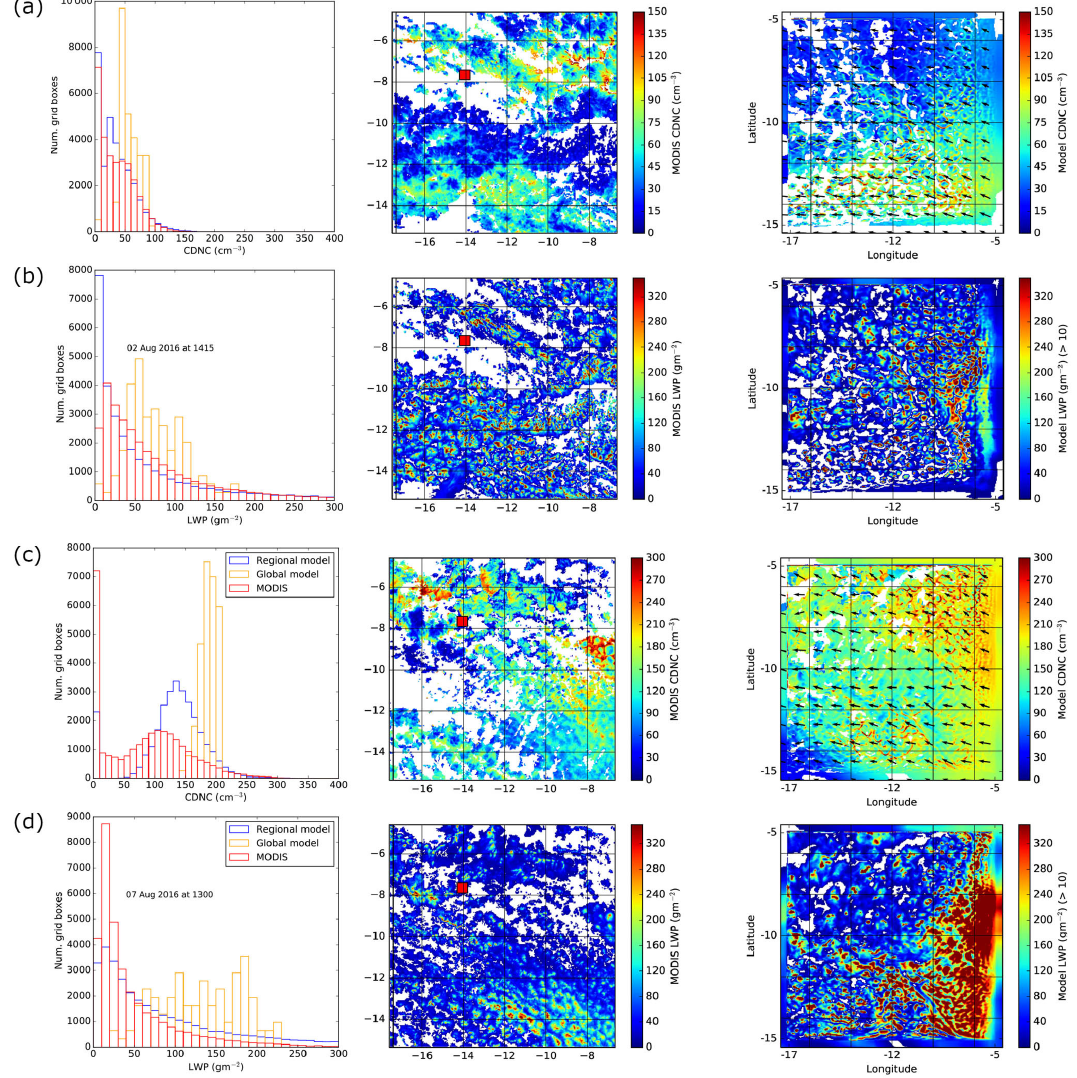
Figure 10. CDNC and LWP from MODIS AQUA and the model on 2 August (a, b) and 7 August (c, d) . Wind vectors at 1260m altitude are shown on the CDNC plot. On 7 August, the lower half of the MODIS CDNC retrieval is compromised by high cloud or aerosol, and the white areas in the CDNC plot that are not present in the LWP plot have been screened out because the cloud top temperature indicates cloud top heights are above the boundary